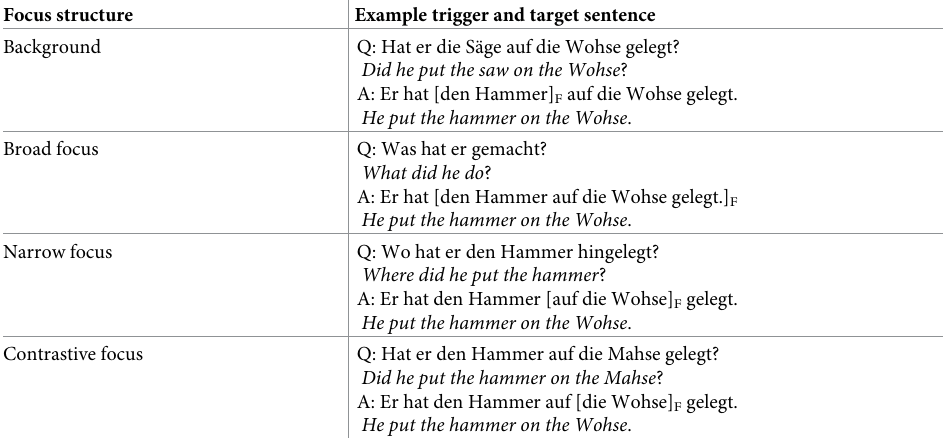
Table 1. Example question-answer-pairs to elicit the focus structures. The target word in these examples is “Wohse”. Focus